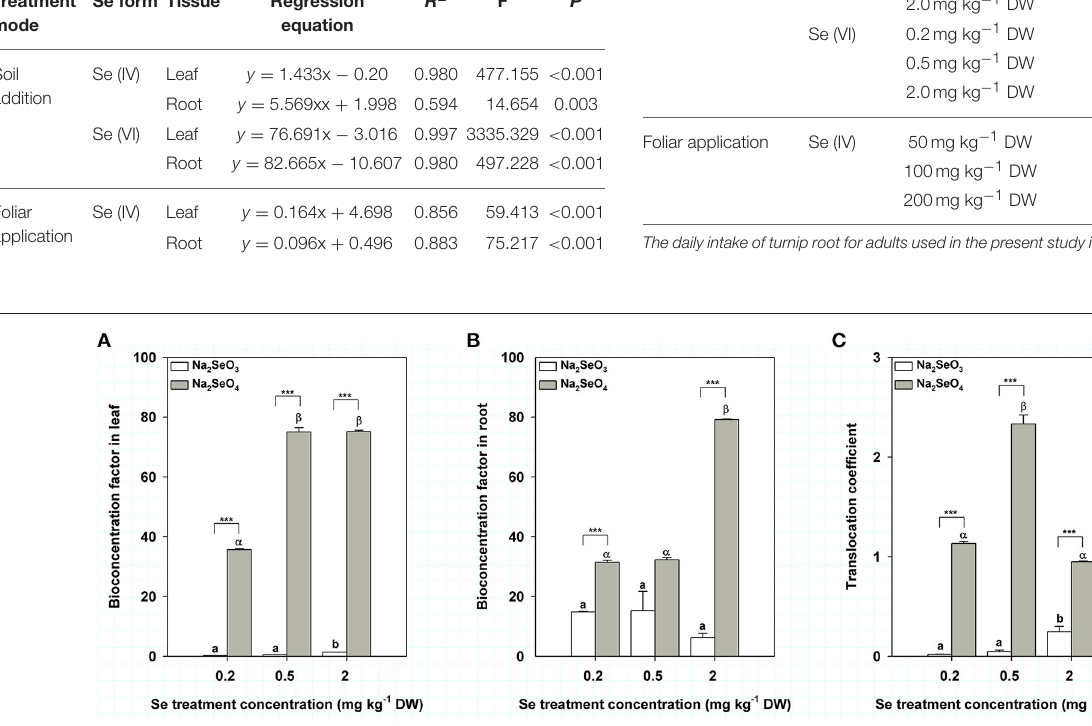
Frontiers in Plant Science |